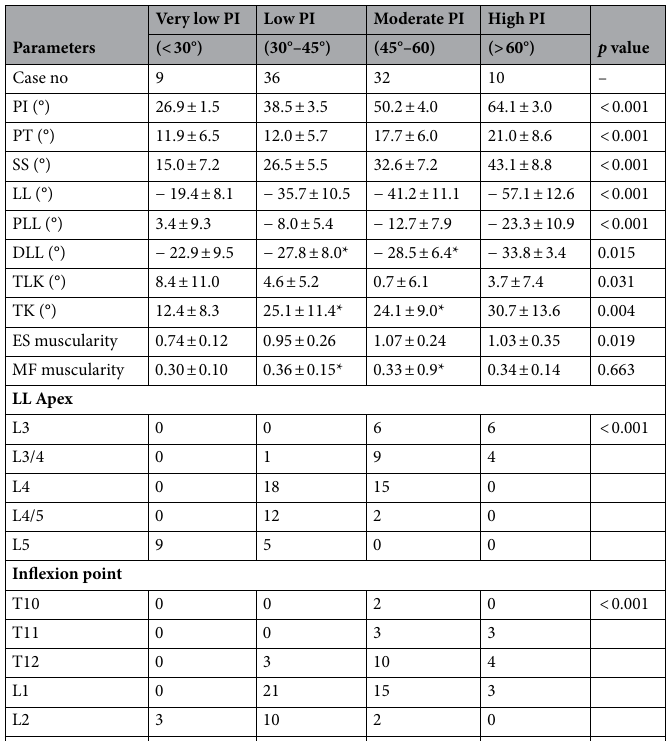
Table 1. Univariance analysis of lumbar lordosis morphology parameters. NO. number, PI pelvic incidence, PLL proximal lumbar lordosis, DLL distal lumbar lordosis, LL Apex lumbar lordosis apex, ES erector spinae, MF multifidus. *Without significance ( p > 0.05) when compared between low PI group and moderate PI group.